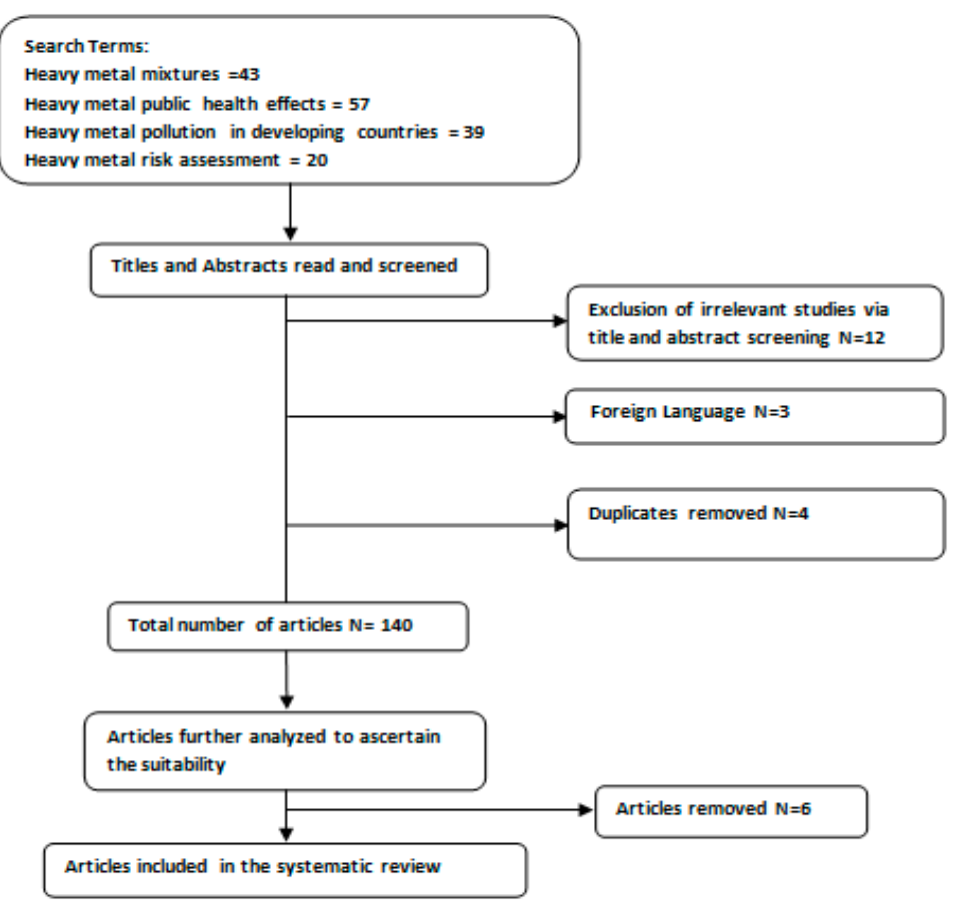
Figure 1. Study selection flow diagram.